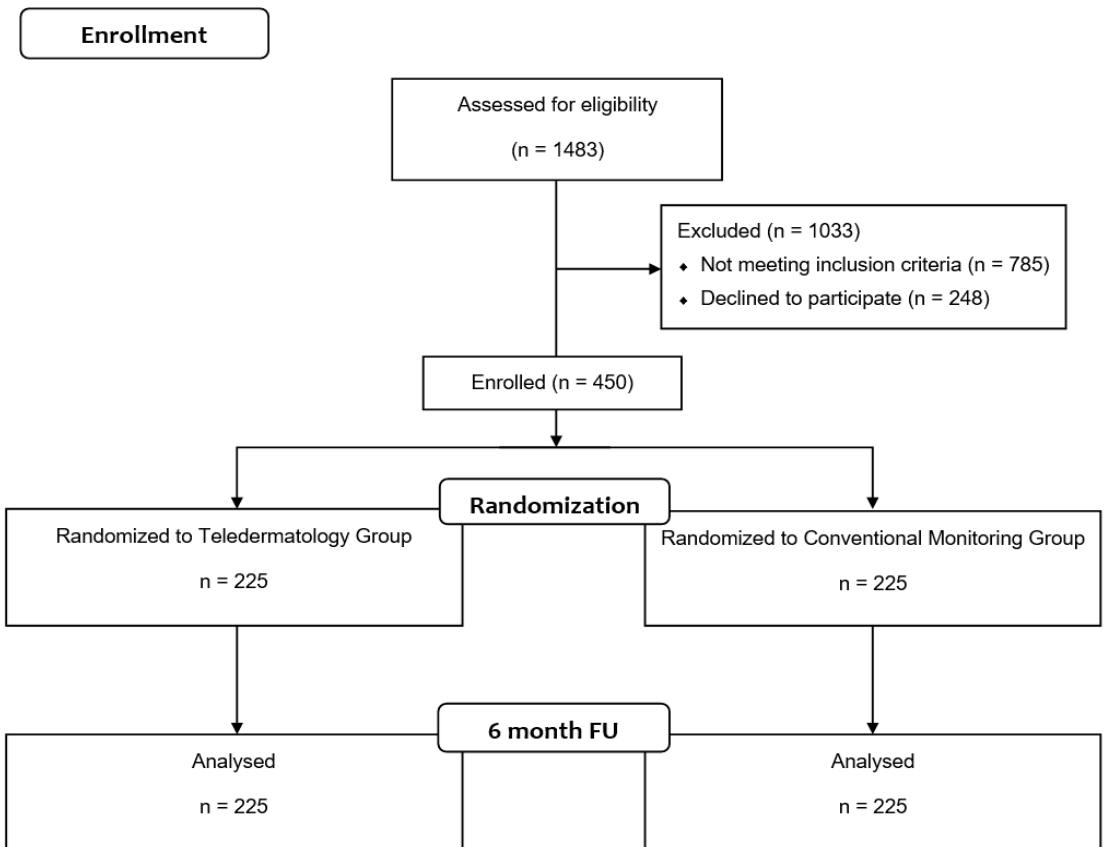
Figure 1. CONSORT Flow Diagram. Table 2. Selected patient baseline characteristics.